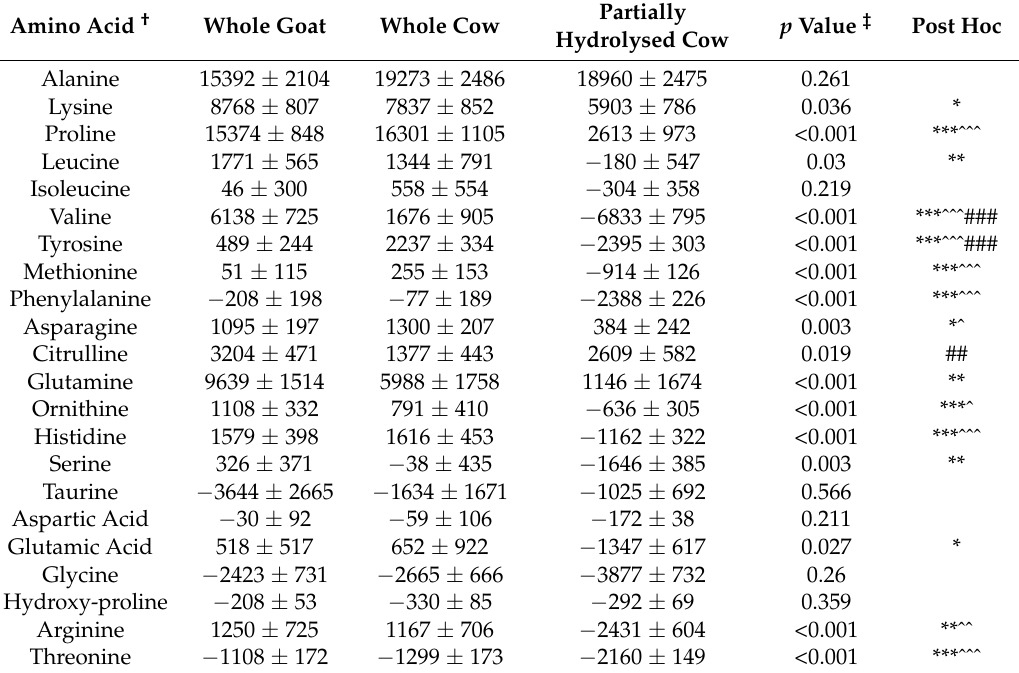
Table 4. Amino acid AUC following whole goat, whole cow, and partially-hydrolysed cow fortified milk. Amino Acid † Whole